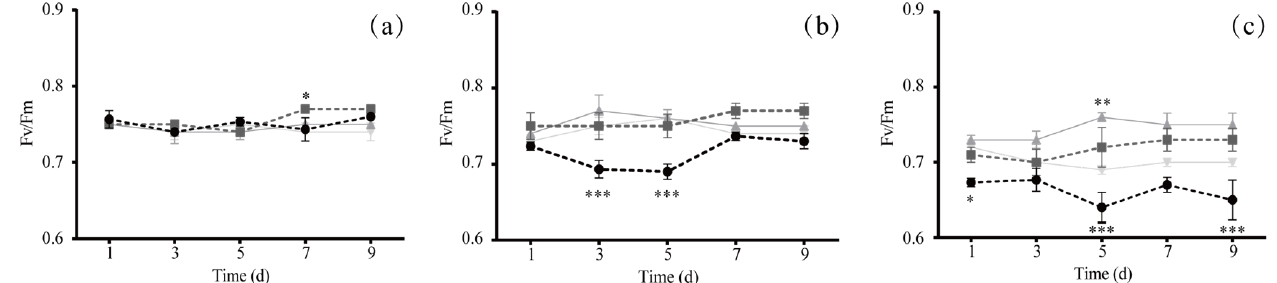
Figure 8. Fv/Fm curves of H. lacustris under light intensities of ( a ) 18 µ mol/m 2 · s, LL; ( b ) 55 µ mol/m 2 · s, ML; ( c ) 110 µ mol/m 2 · s, HL. Continuous light (black circle), 2/2 s (black box), 2/2 h (gray triangle), and 6/6 h (gray inverted triangle). Error bars show the standard deviation for three replicates. Asterisks indicate statistically significant differences resulting from Student’s t -tests: * p < 0.05, ** p < 0.01, *** p < 0.001. The astaxanthin and ROS concentrations remained at low levels under the light/dark cycle, indicating less damage. Comparing Figure 9a–f, it can be seen that the values of the astaxanthin and ROS concentrations could be maintained at a lower level under all light intensities. However, with continuous light treatment, the highest astaxanthin concentration (Figure 9c, 4.94 × 10 − 11 g/cell, p < 0.05) and ROS concentration (Figure 9f, 0.964 units per cell, p < 0.05) occurred on day 7, indicating cell